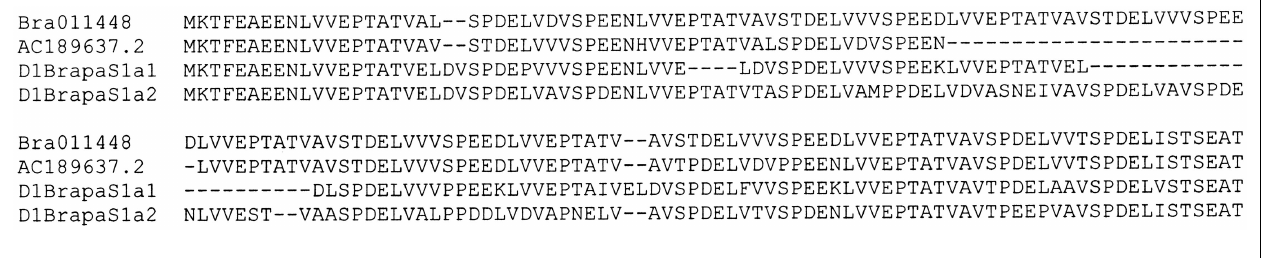
within the marker D1BrapaS1 . AC189637.2 and Bra011448 are Chinese cabbage sequences from public databases and D1BrapaS1a1